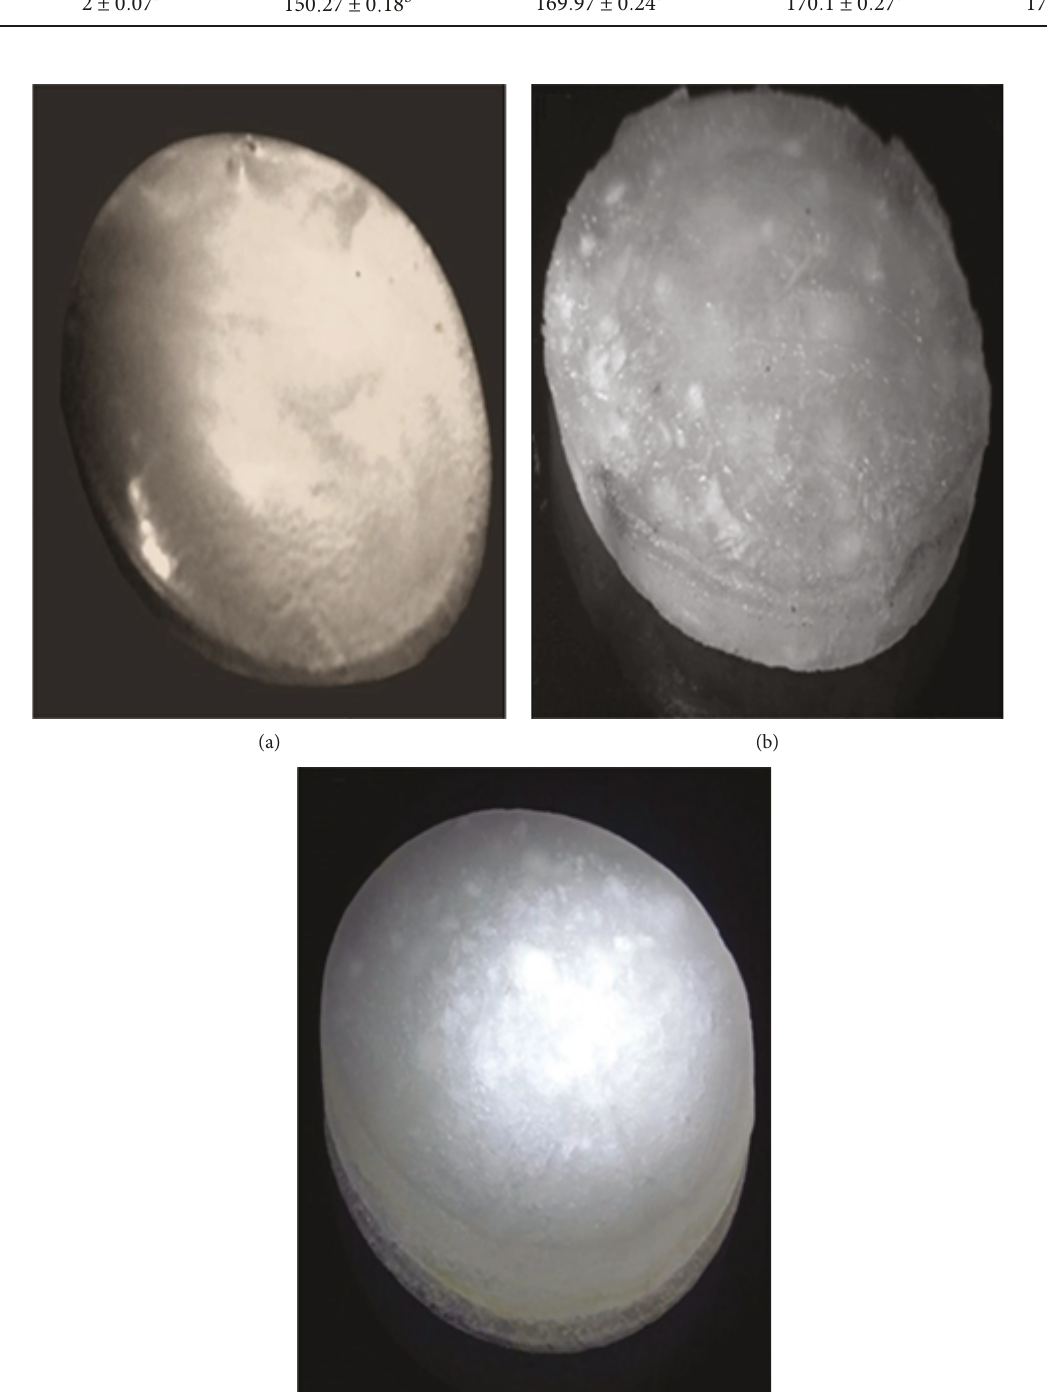
Figure 6: Water holding ability of the prepared hydrogels: (a) state of HGE prior to swelling; (b) state of HGE after 2 hours of swelling; (c) state of HGE after 8 hours of